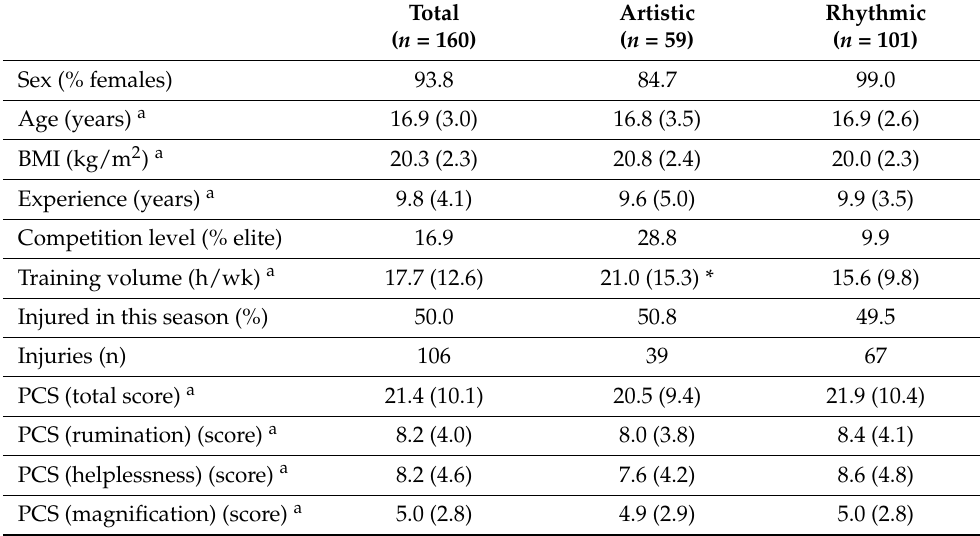
Table 1. Sociodemographic characteristics, injuries, pain level, and catastrophizing level for all